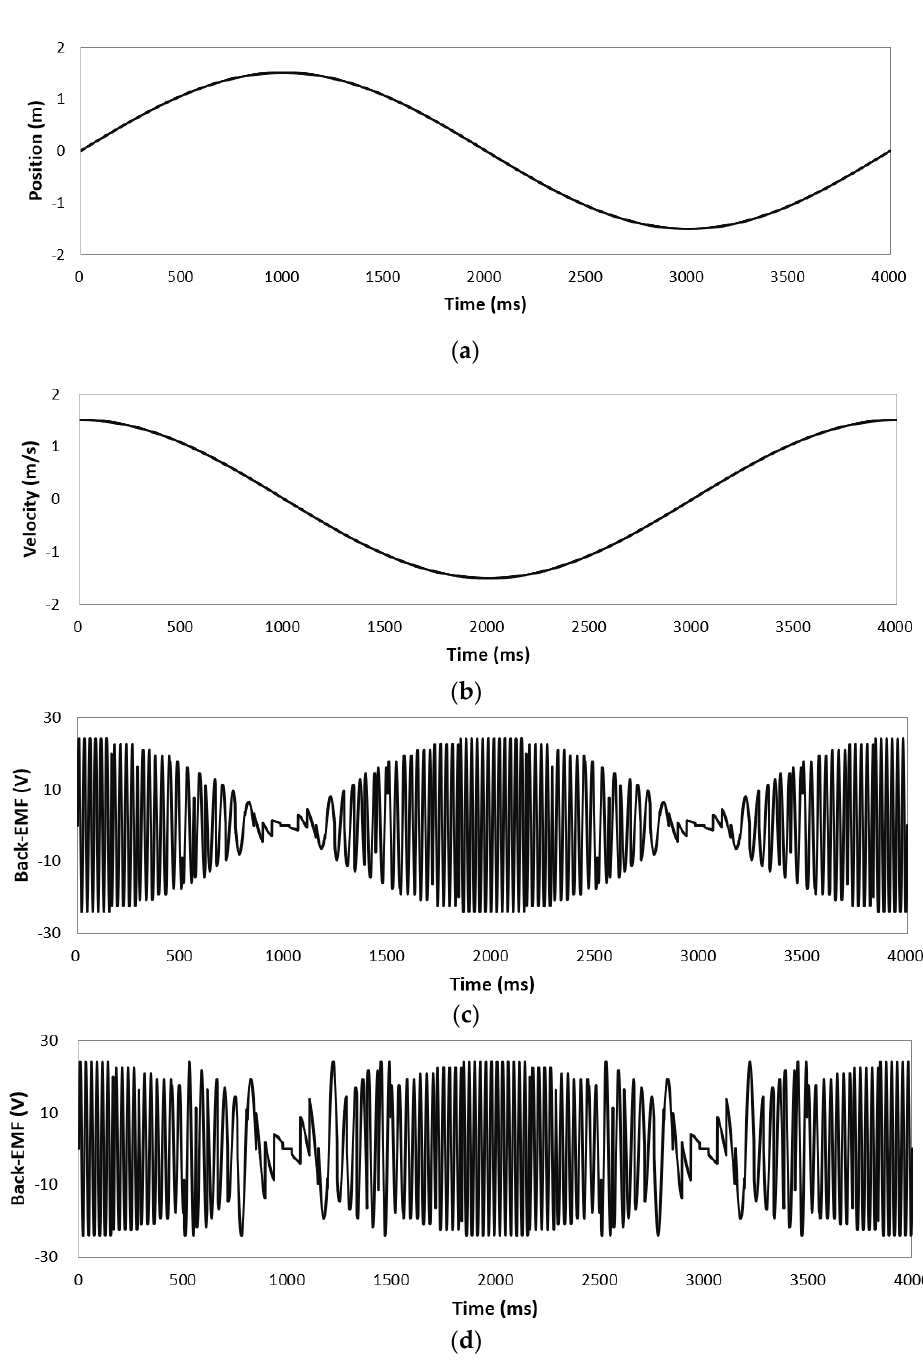
Figure 10. ( a ) The translator position in a wave; ( b ) the translator velocity; ( c ) the back-EMF without flux regulation; and ( d ) the back-EMF with flux